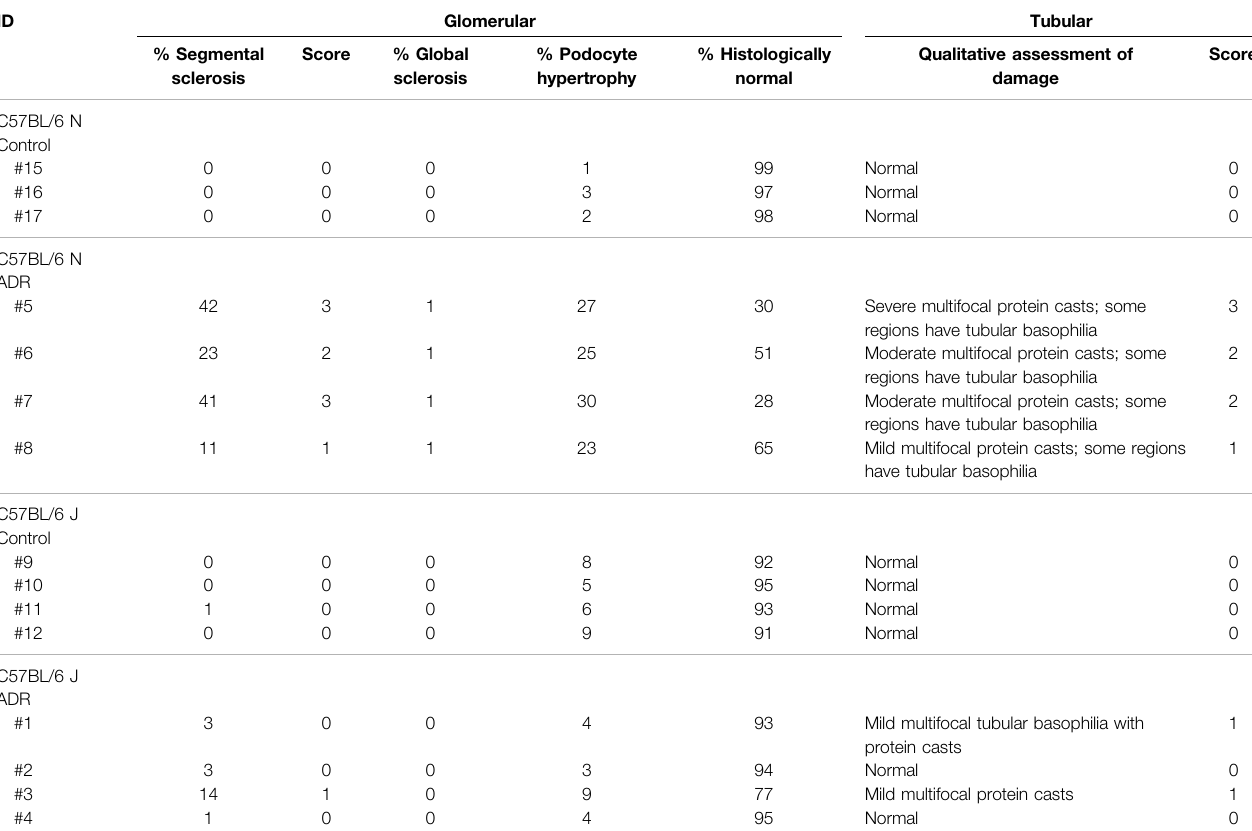
TABLE 1 | Histological Scoring of ADR-Induced Nephropathy in both N and J